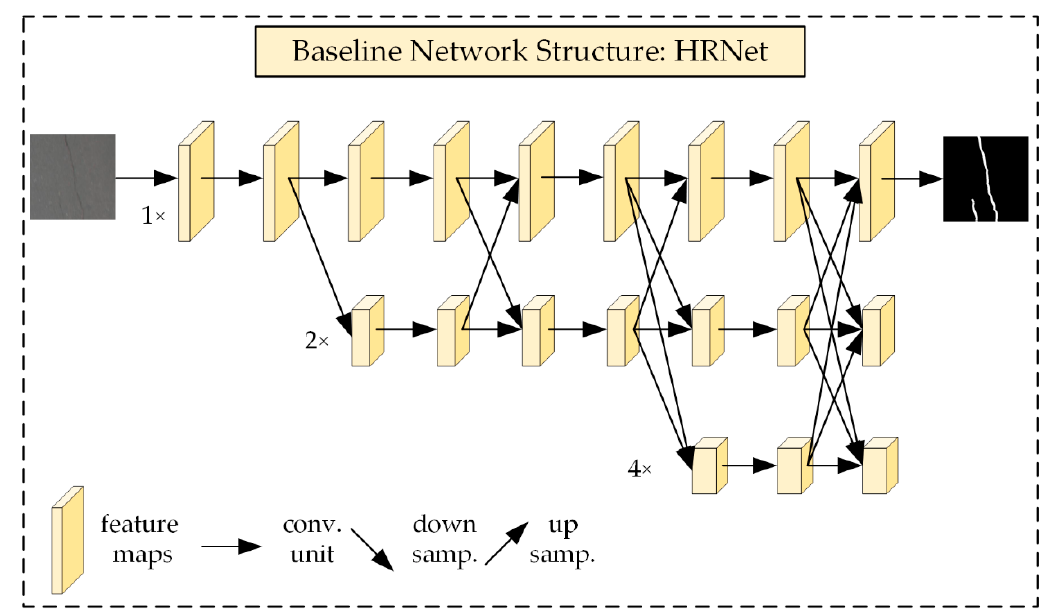
Figure 6. HRNet structure schematic (1×, 2×, 4× are sampling scales).